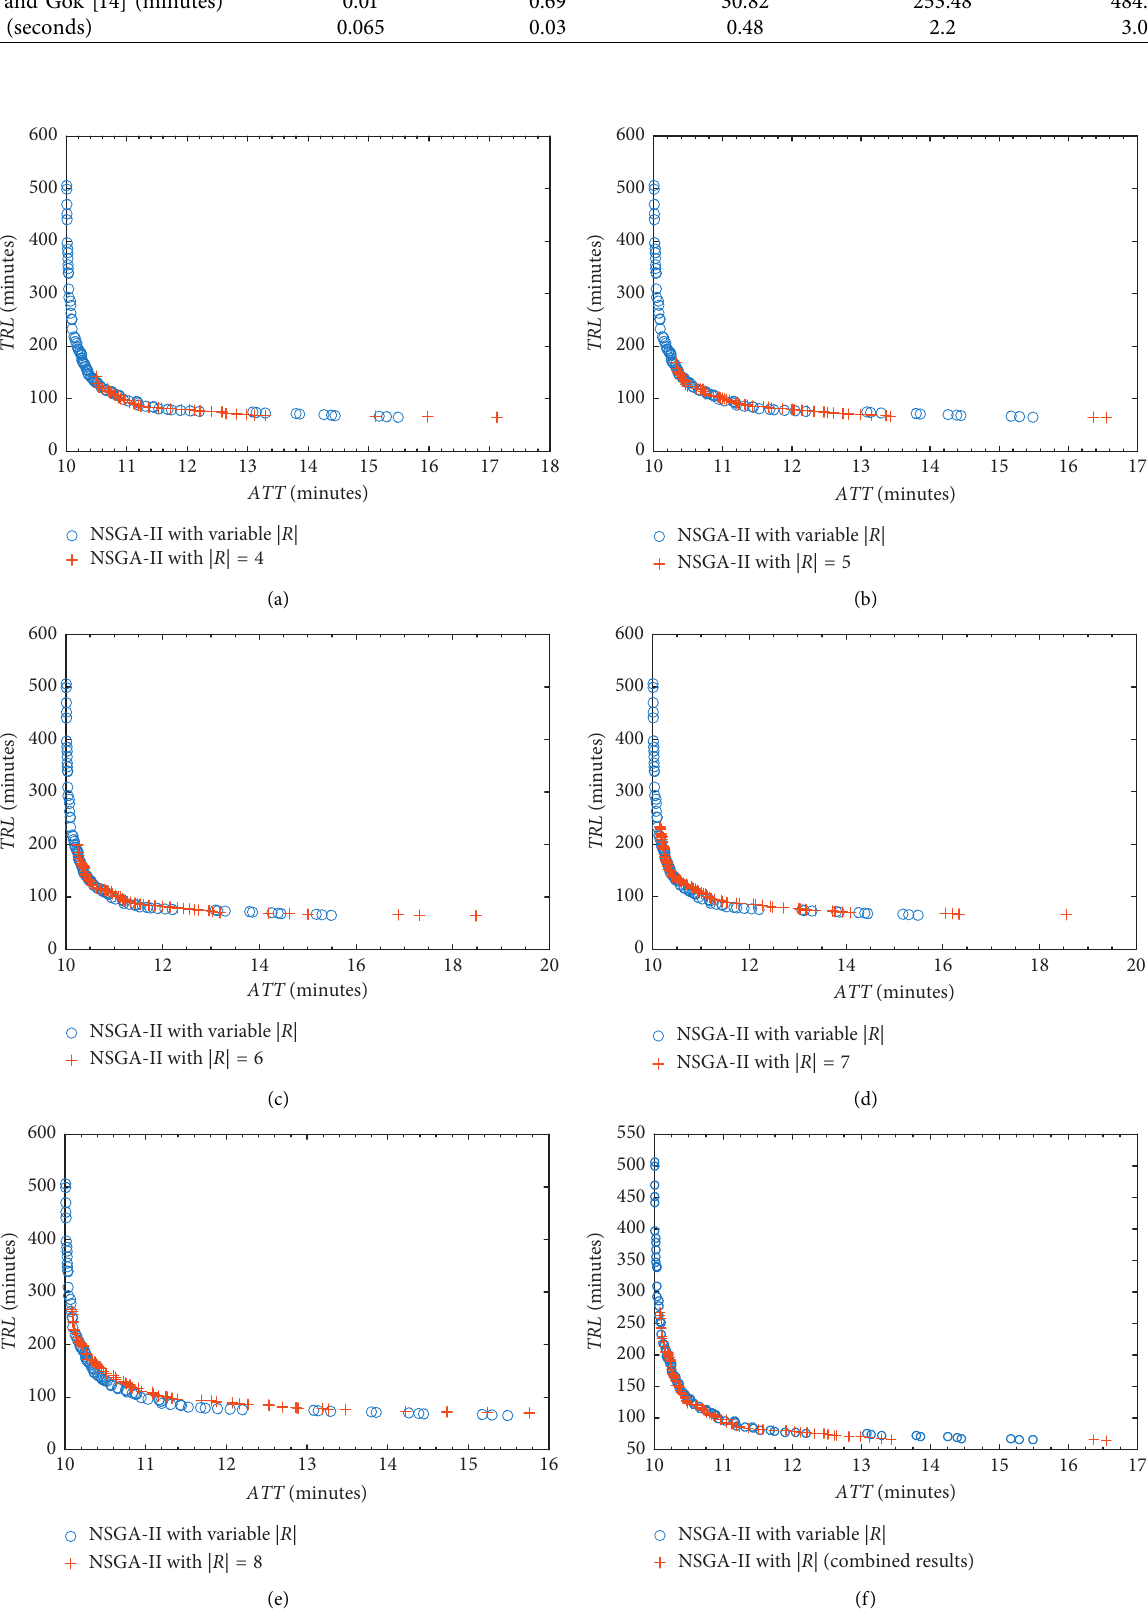
Figure 8: Approximate Pareto fronts generated by the NSGA-II with variable and fixed | R | for Mandl’s network. (a) Fixed | R | � 4. (b) Fixed | R | � 5. (c) Fixed | R | � 6. (d) Fixed | R | � 7. (e) Fixed | R | � 8. (f) Fixed | R | � 4 −